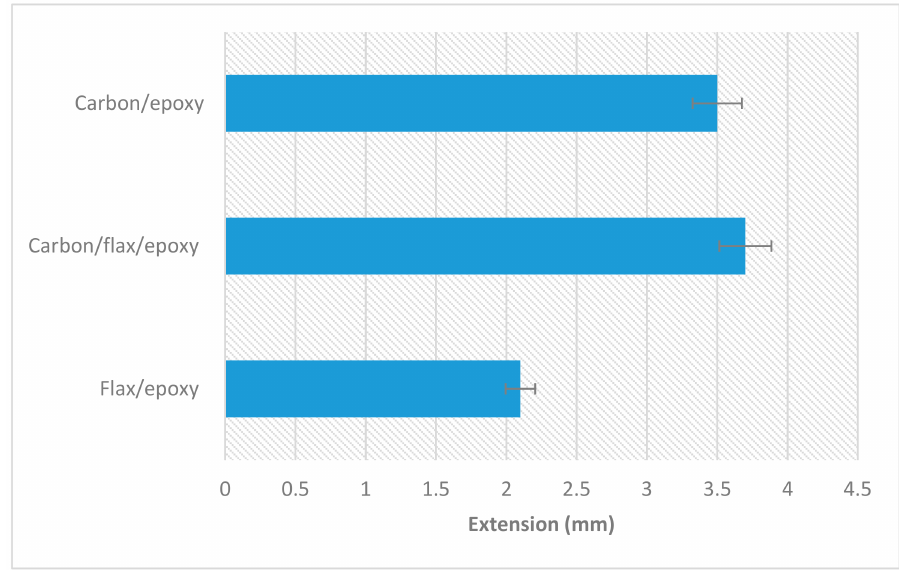
Figure 3. Comparative results for maximum extension at break for di ff erent